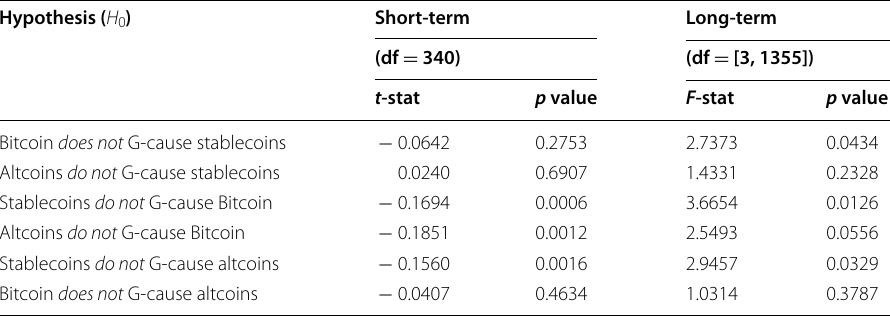
Table 7 Granger causality on market capitalizations for year